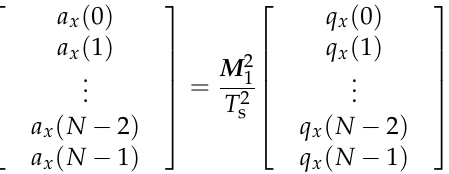
Figure 4. The process of solving the acceleration of X-axis: ( a ) the process of calculating the acceler- ation sequence; ( b ) the process of filtering the acceleration sequence. First, the design of the FIR low-pass filter needs to be carried out, which means ob- taining the value of ℎ(𝑖) in Figure 4b. Let the frequency characteristics of the ideal linear- phase FIR low-pass filter be